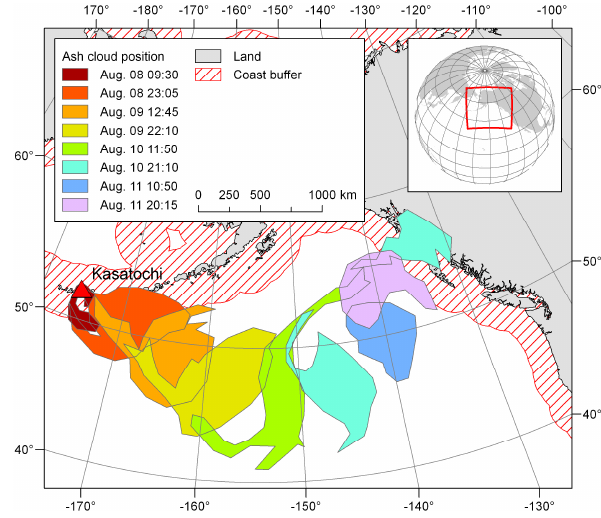
Fig. 2. Atmospheric dispersion of the Kasatochi ash cloud from 8 August to 11 August 2008 based on MODIS level 1b data at 11 and 12µm using Figure 2. Atmospheric dispersion of the Kasatochi ash cloud from August 8 to August 11, 3 2008 based on MODIS level 1b data at 11 and 12 µ m using BTD. 4